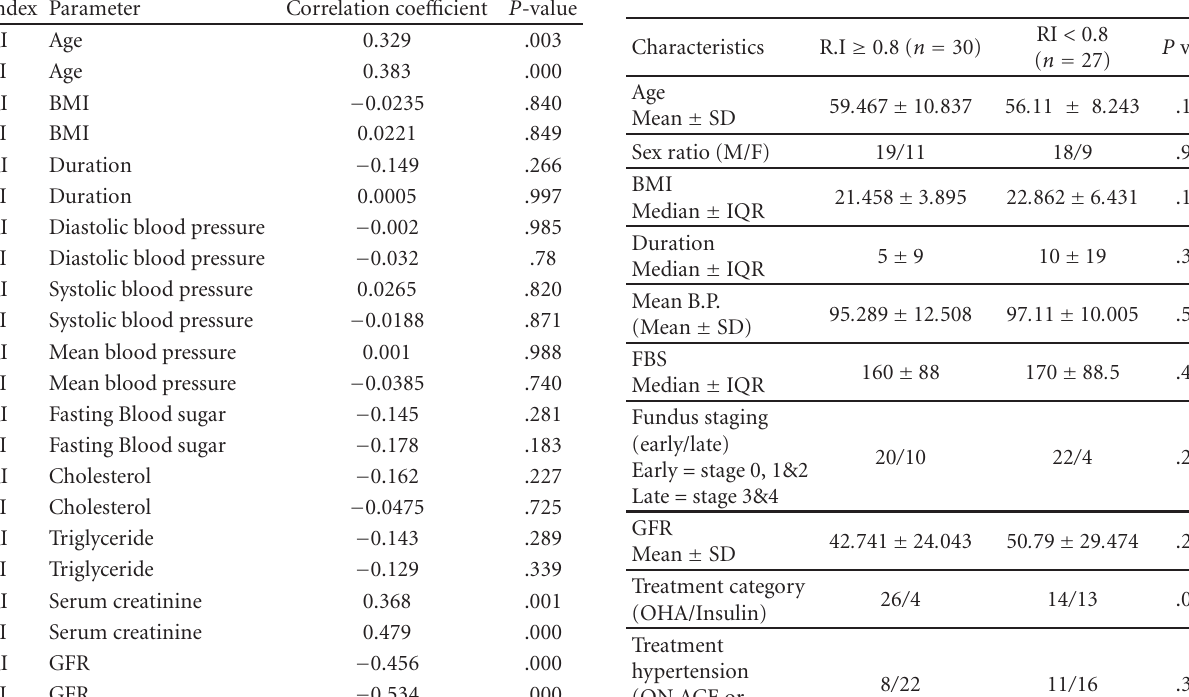
Table 3: Correlation of RI and PI with various variables. Table 4: Comparison of patients with or without raised vascular